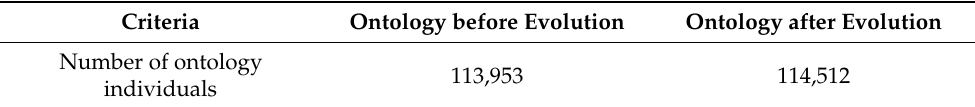
Table 1. Ontology evolution results. Criteria Ontology before Evolution Ontology after Evolution Number of